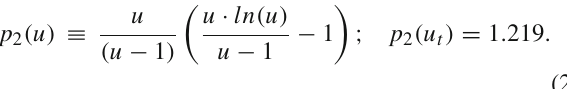
given by expressions like in (58), also with masses permuted for different